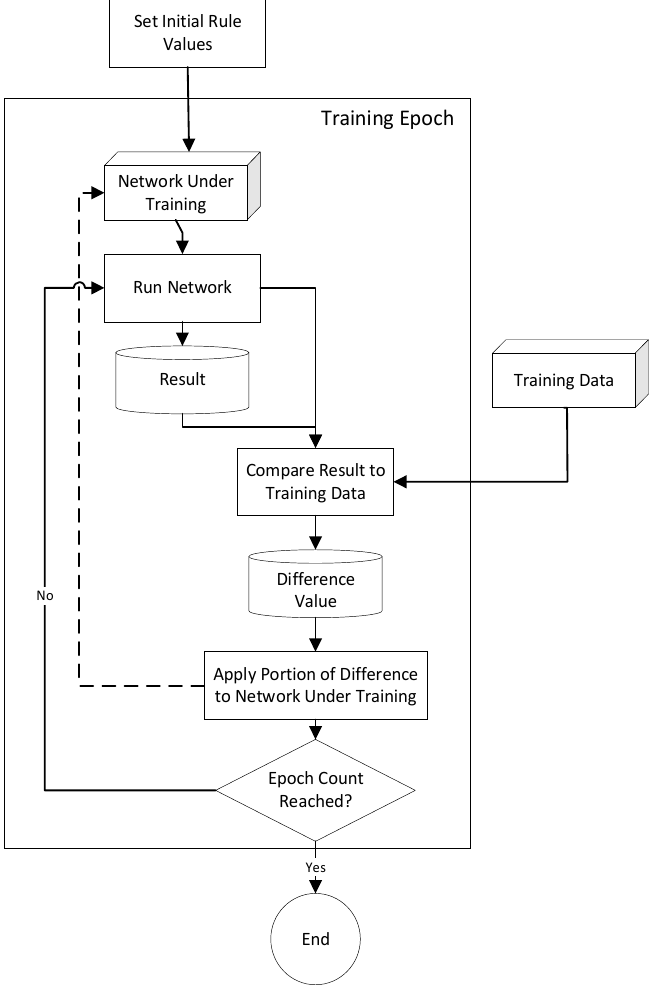
Figure 1. Gradient descent expert system training algorithm [45].